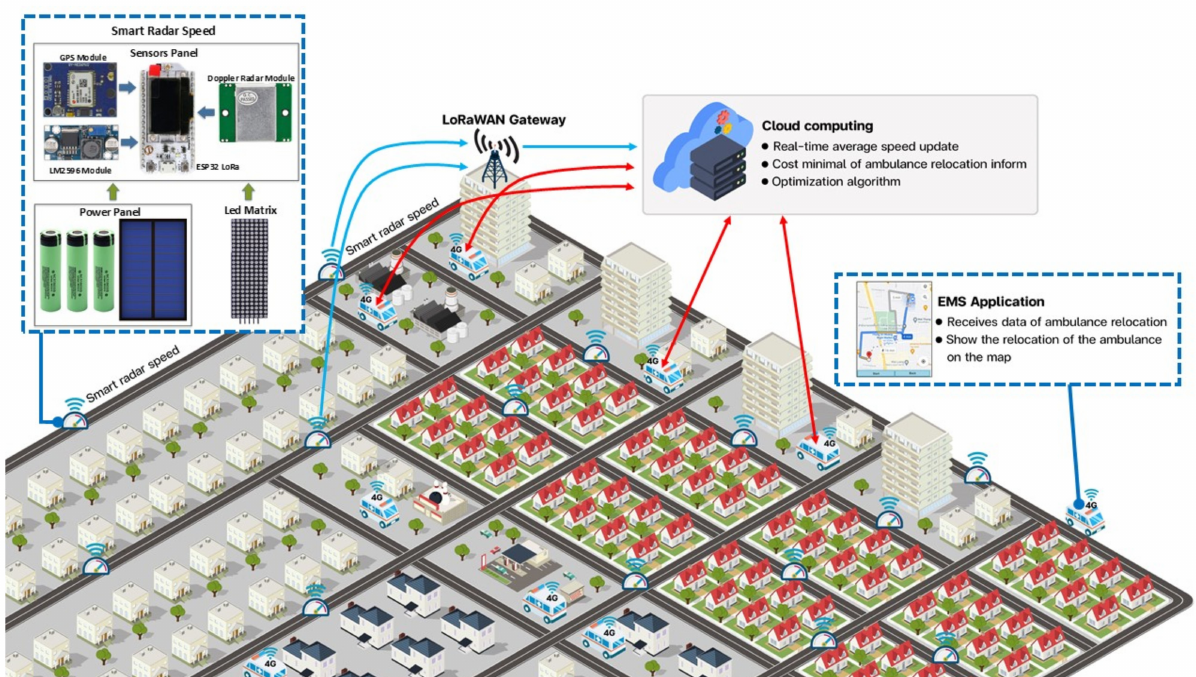
Figure 2. The proposed architecture